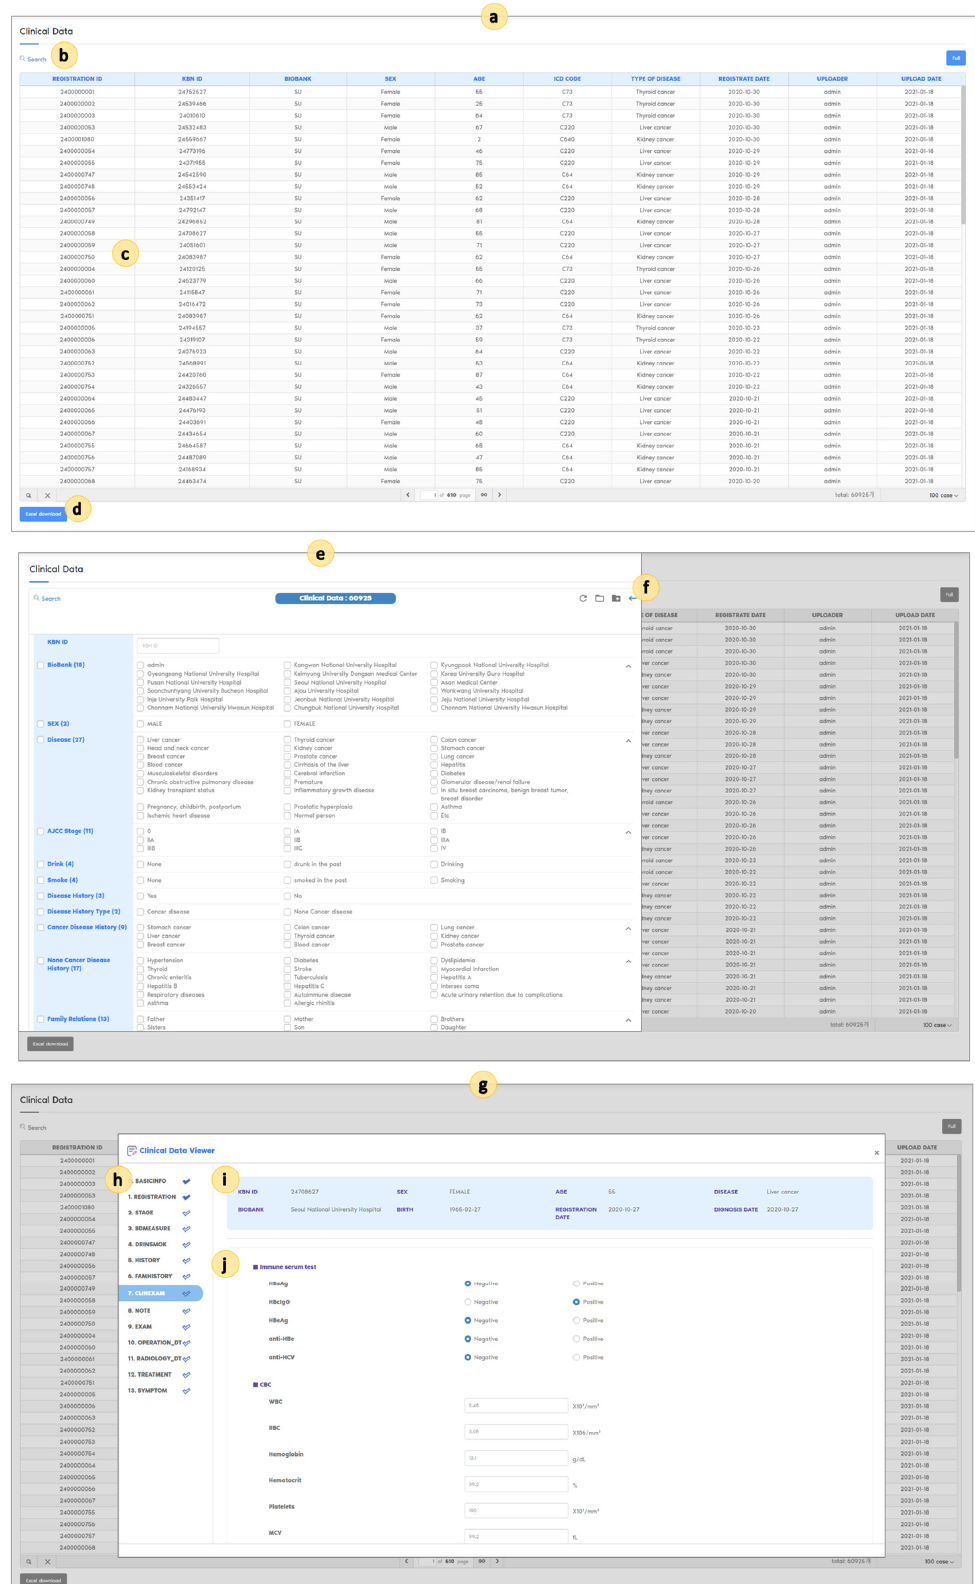
Figure 5. Clinical information search screenshot ( a ) first page, ( b ) search button, ( c ) row data, ( d ) Excel download, ( e ) sliding menu for filtering, ( f ) apply button, ( g ) clinical data viewer, ( h ) table list, ( i ) basic patient information, and ( j ) clinical